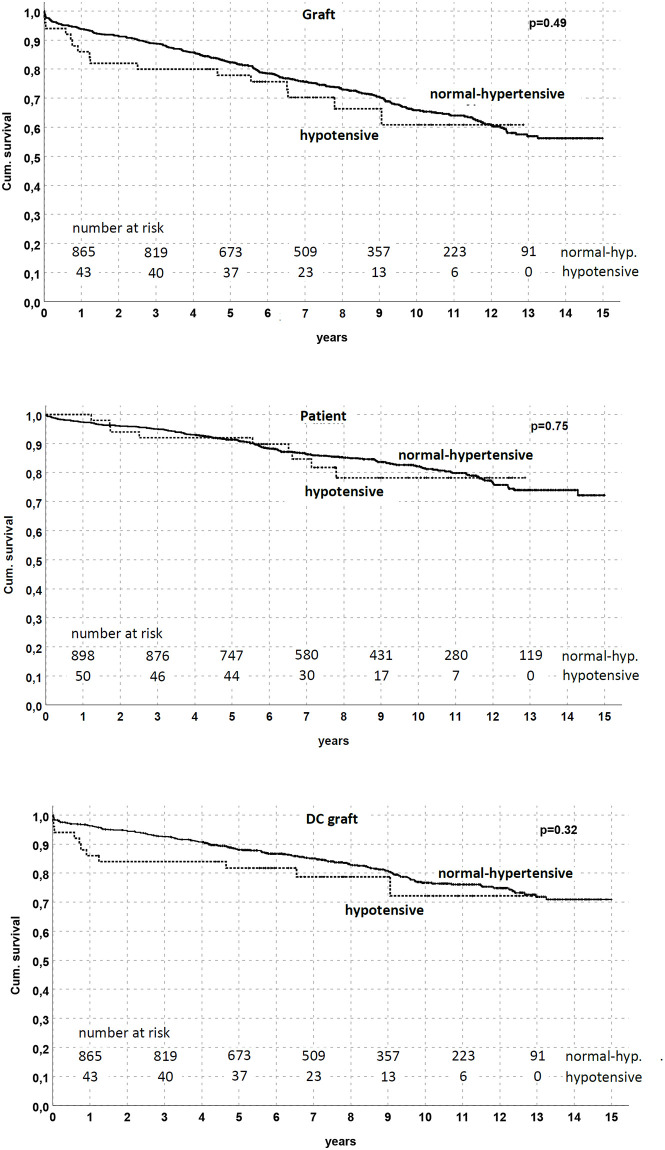
Graft and patient survival by pre-existing blood pressure status in the studied population.No difference was noted between the hypotensive and normal-hypertensive groups (p = NS in all analyses).